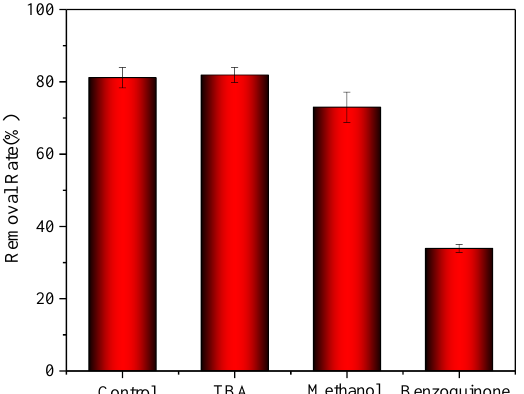
Figure 8. Photocatalytic degradation of MO over Ni/Cr(2/1)−0.5LA LDH with different free radical trapping agents.